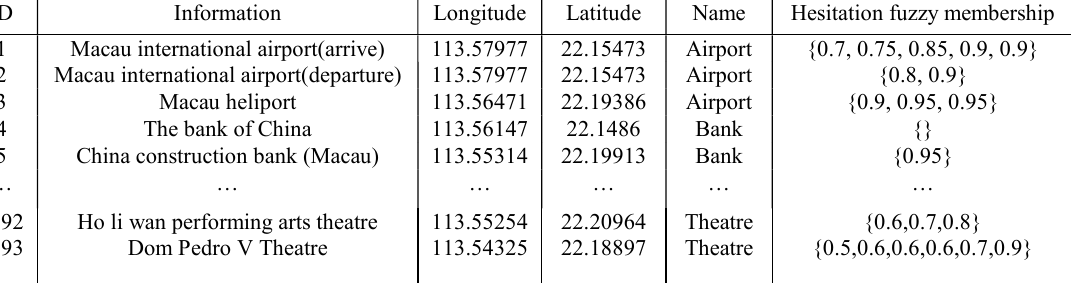
Table 1. Attributes of hesitant fuzzy instances